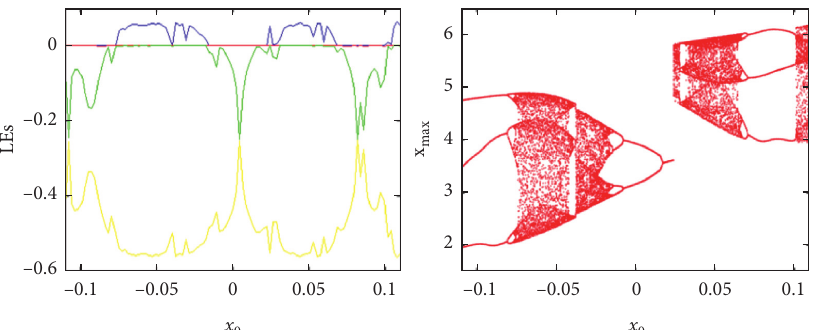
Figure 10: Dynamical evolution of system (1) with (a) � 0.8, (b) � 0.5, (c) � 1, (d) � 0.1 and initial condition IC � ( x in [ − 0.11, 0.11]: (a) Lyapunov exponent spectrum and (b) bifurcation